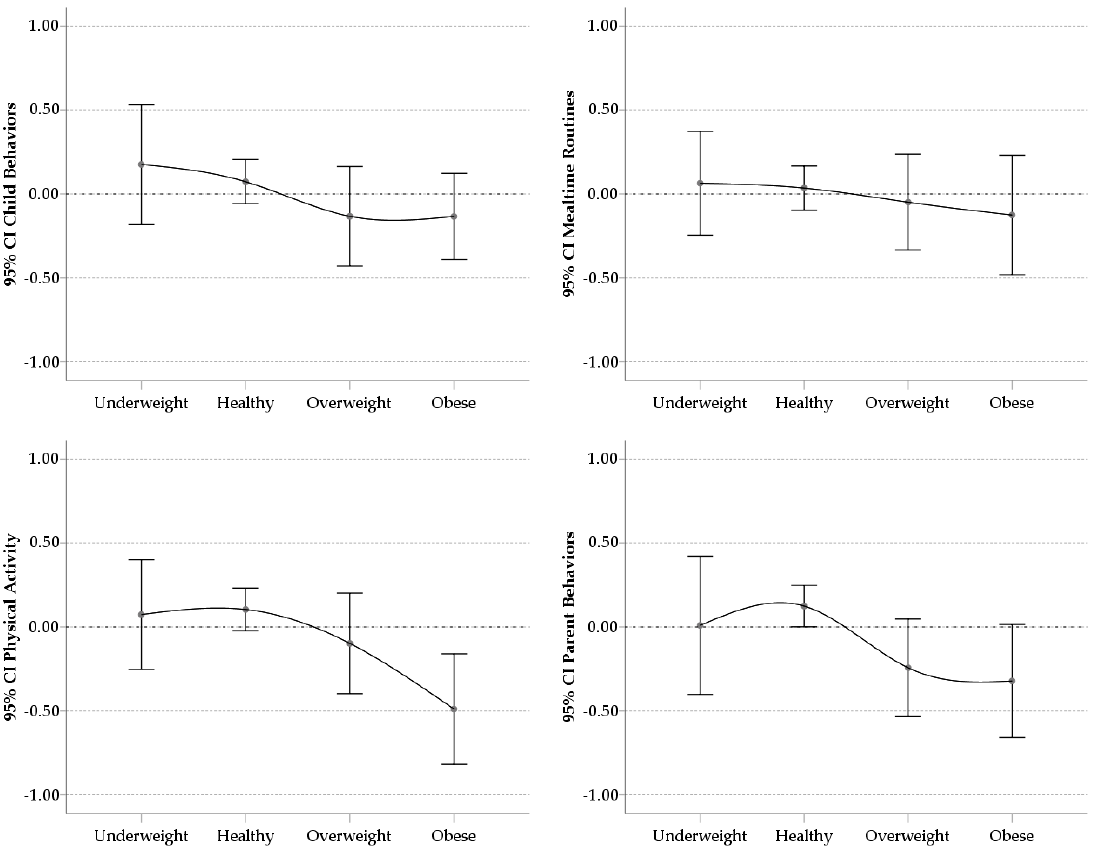
Figure 1. Means and 95% Confidence Intervals of the factor scores for the BMI classification groups.